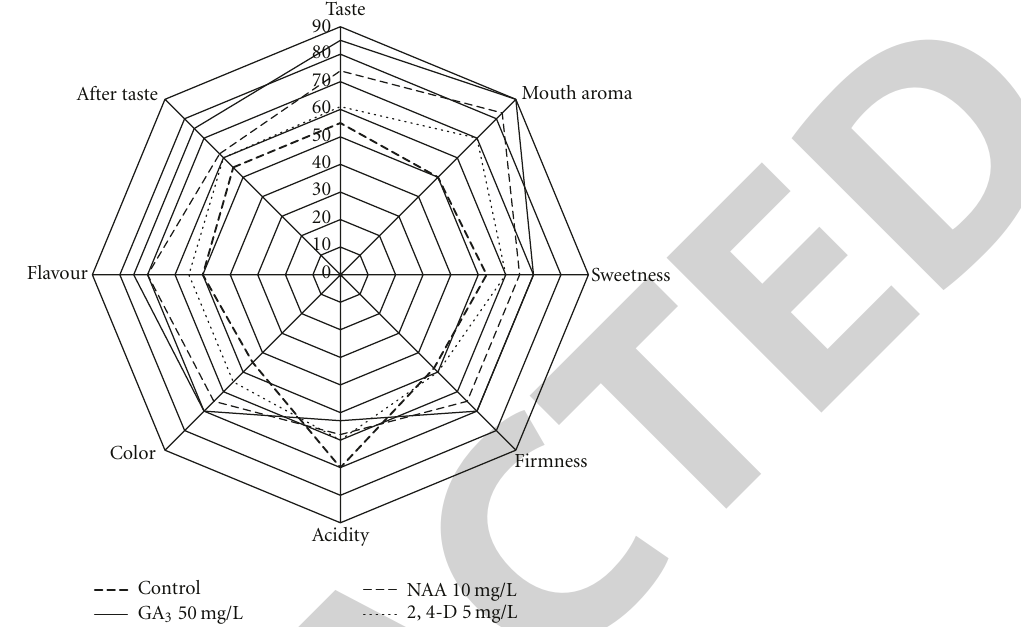
Figure 4: Taste panel scoring of fruits from the GA 3 , NAA and 2,4-D treatments, based on the examined quality